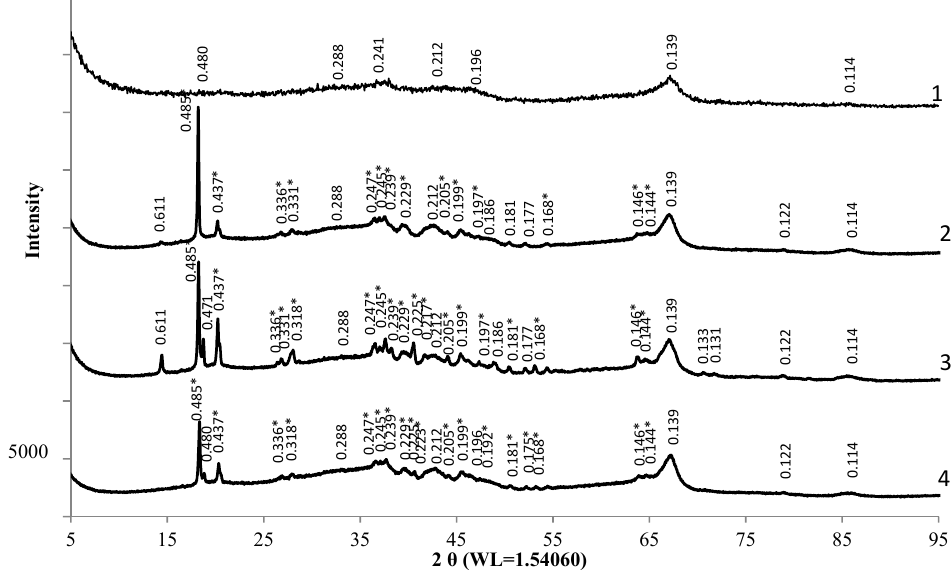
Figure 3. Diffractograms of (1) starting χ‐ Al 2 O 3 and its products of HTT at (2) Т = 190 ° С , рН = 4.0, τ = 40 min, (3) Т = 180 ° С , рН = 9.2, τ = 40 min, and (4) Т = 150 ° С , рН = 9.2, τ = 40 min in the mode of temperature rise. “*”: gibbsite.